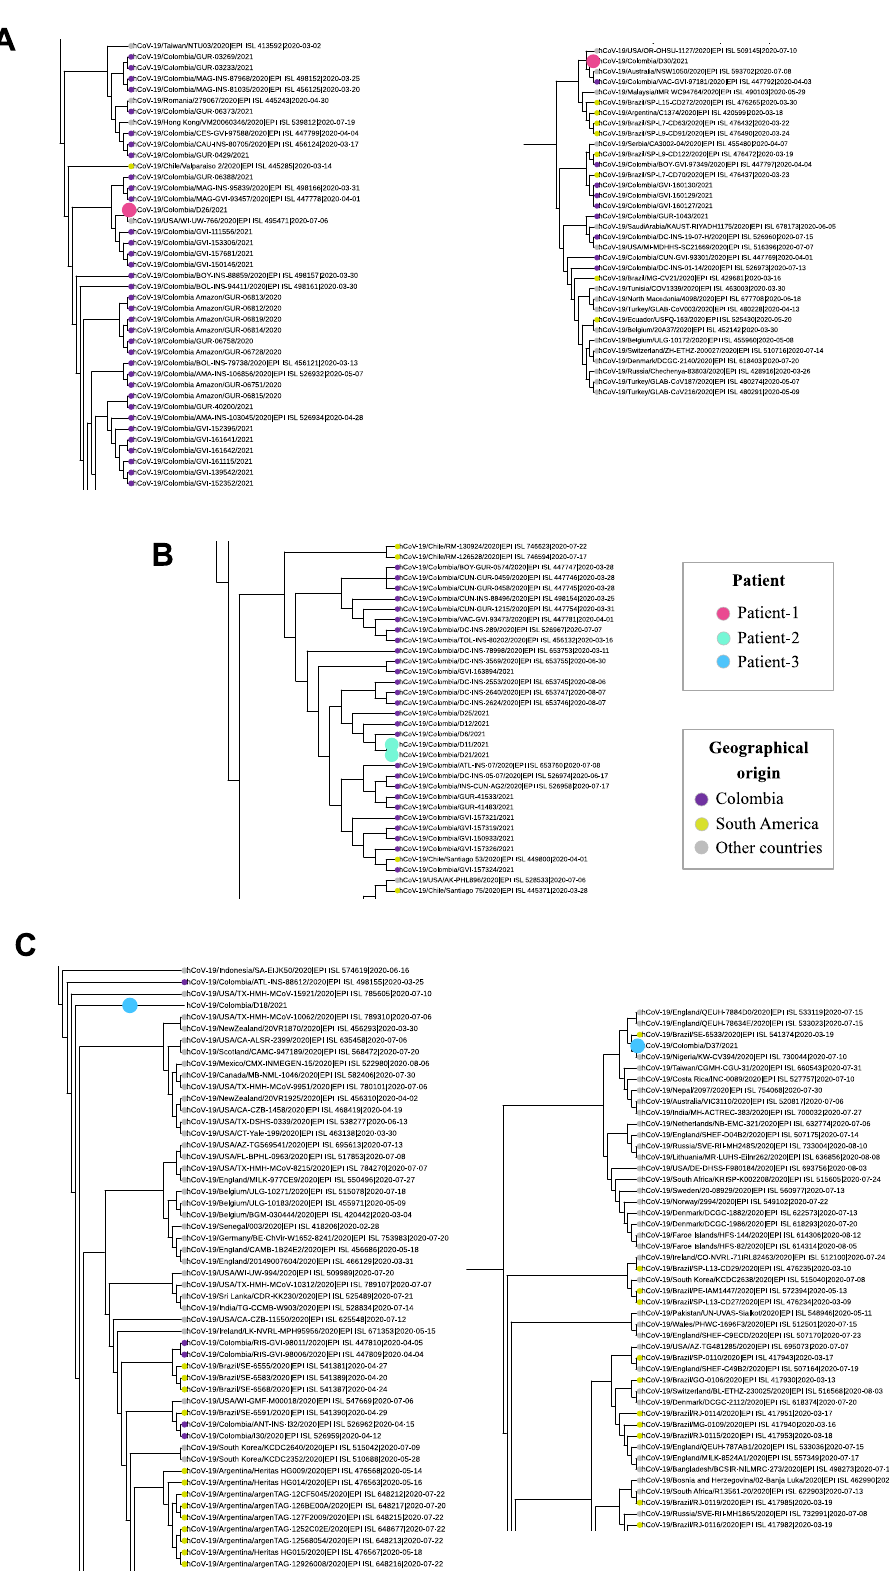
Figure 3. Phylogenetic relationships for the paired genome assemblies obtained from each patient. A zoom to which each of the analyzed genomes belongs was carried out to identify the geographical origin of the most closely related genomes: ( A ) Patient 1; ( B ) Patient 2; ( C ) Patient 3.